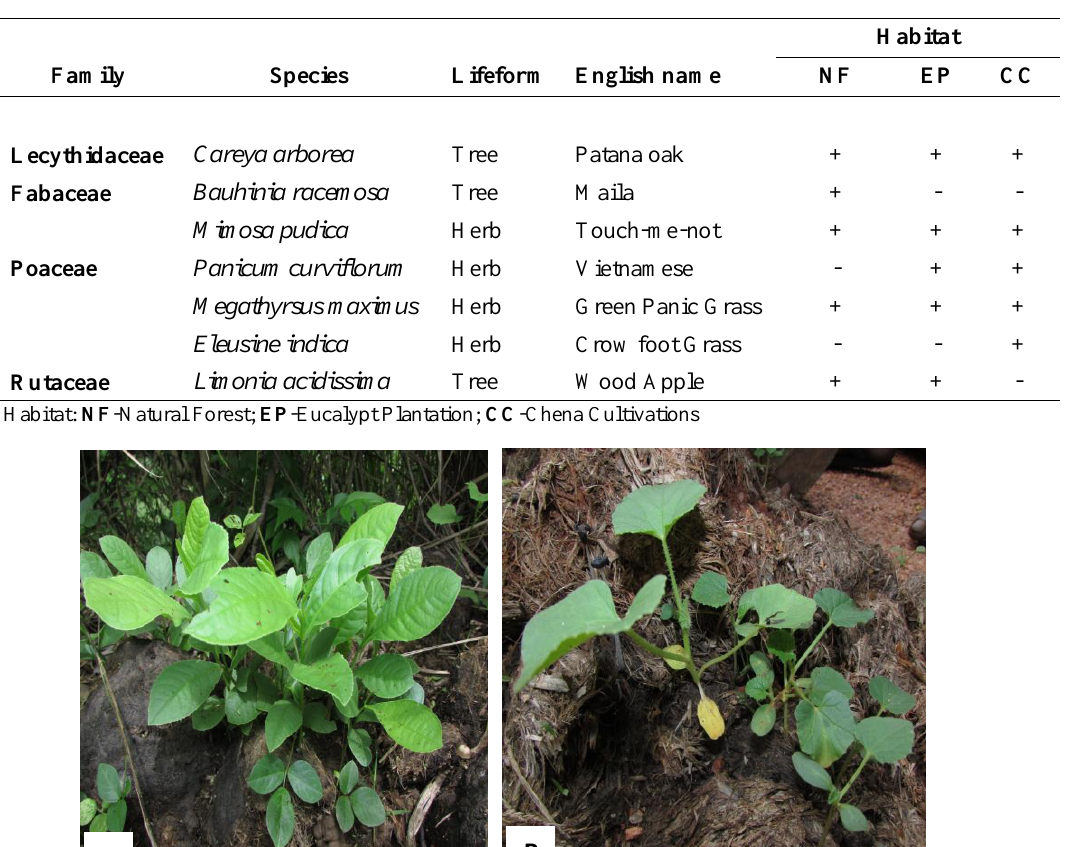
Table 2: List of non-cultivated plant seeds which were dispersed by the elephants in the study area.